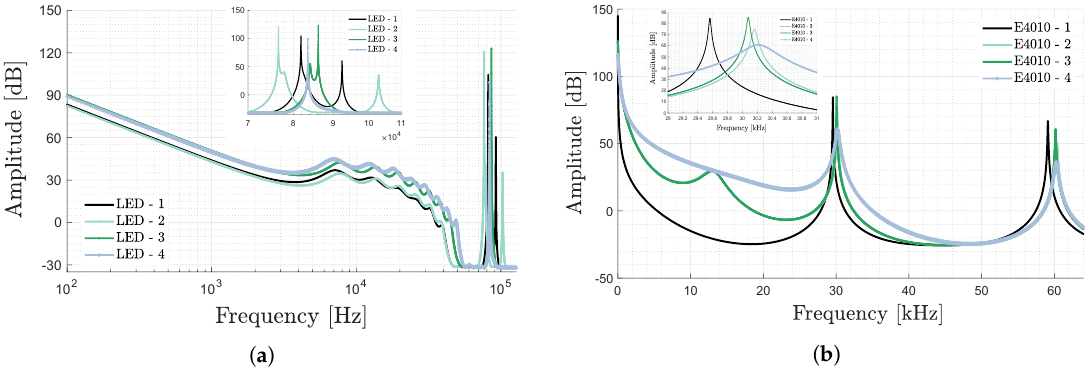
Figure 4. MUSIC pseudospectrum versus frequency on ( a ) a logarithmic scale of 4 LTM8005 demo boards each driving a BXRE COB LED (subspace order 20), and ( b ) on a linear scale of 4 ETAP E410 LED